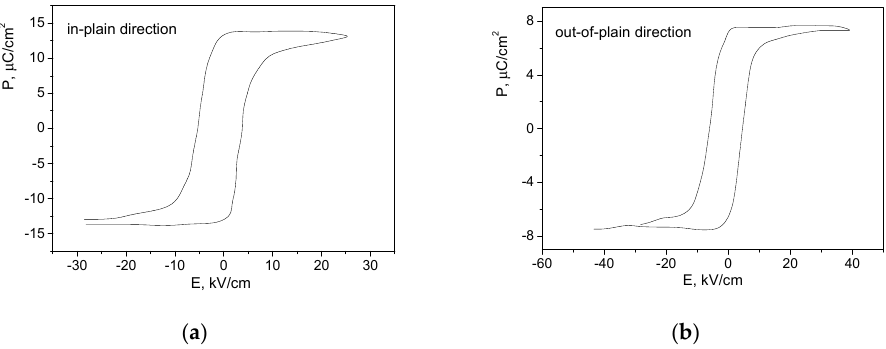
Figure 3. Polarization curves and hysteresis loops of BST/PVDF-TrFE coating measured for ( a ) in- plain and ( b ) out-of-plain devices.